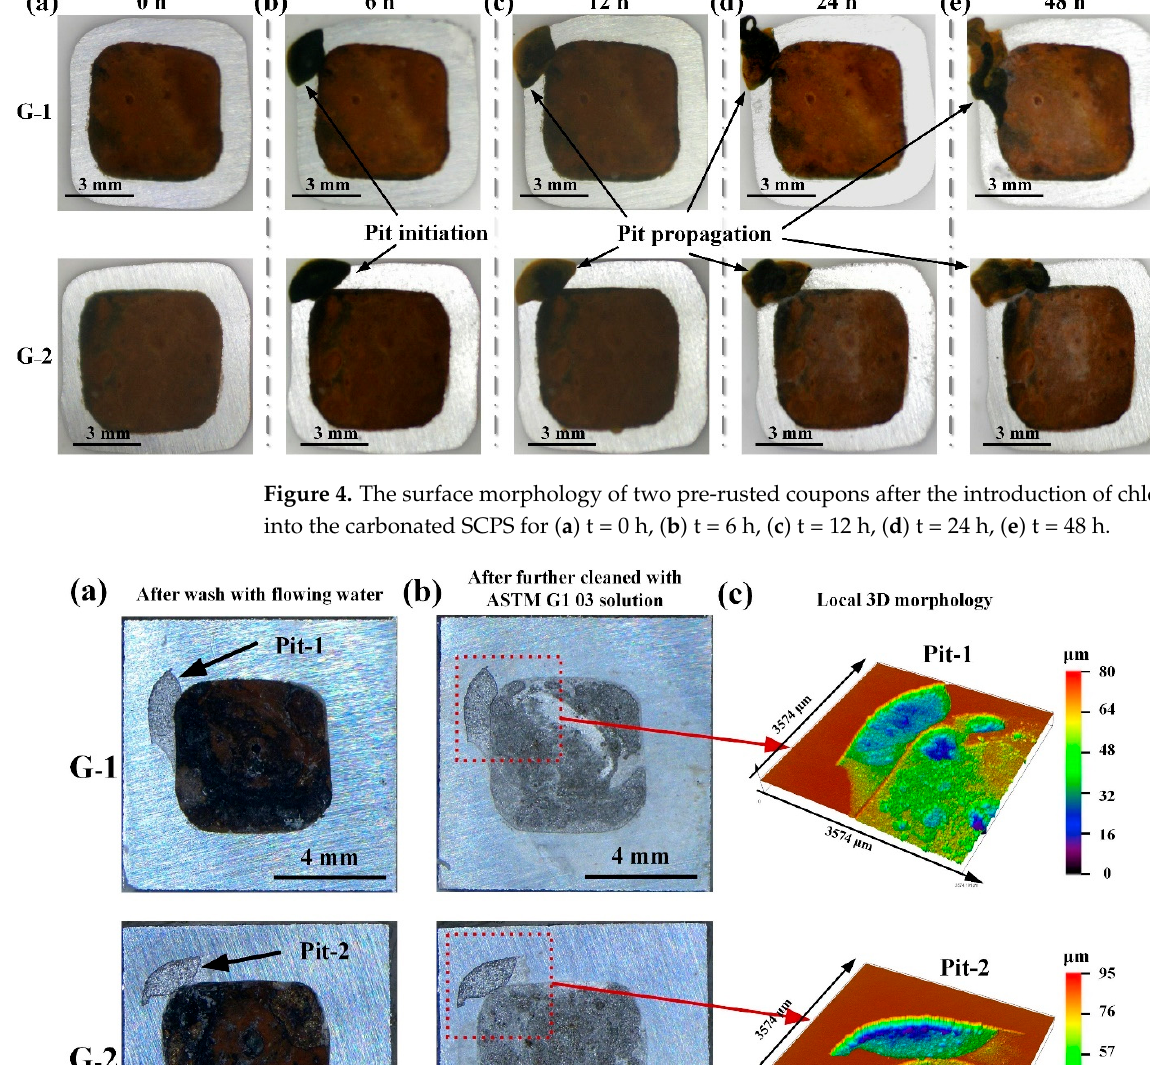
Figure 4. The surface morphology of two pre-rusted coupons after the introduction of chloride ions into the carbonated SCPS for ( a ) t = 0 h, ( b ) t = 6 h, ( c ) t = 12 h, ( d ) t = 24 h, ( e ) t = 48 h.